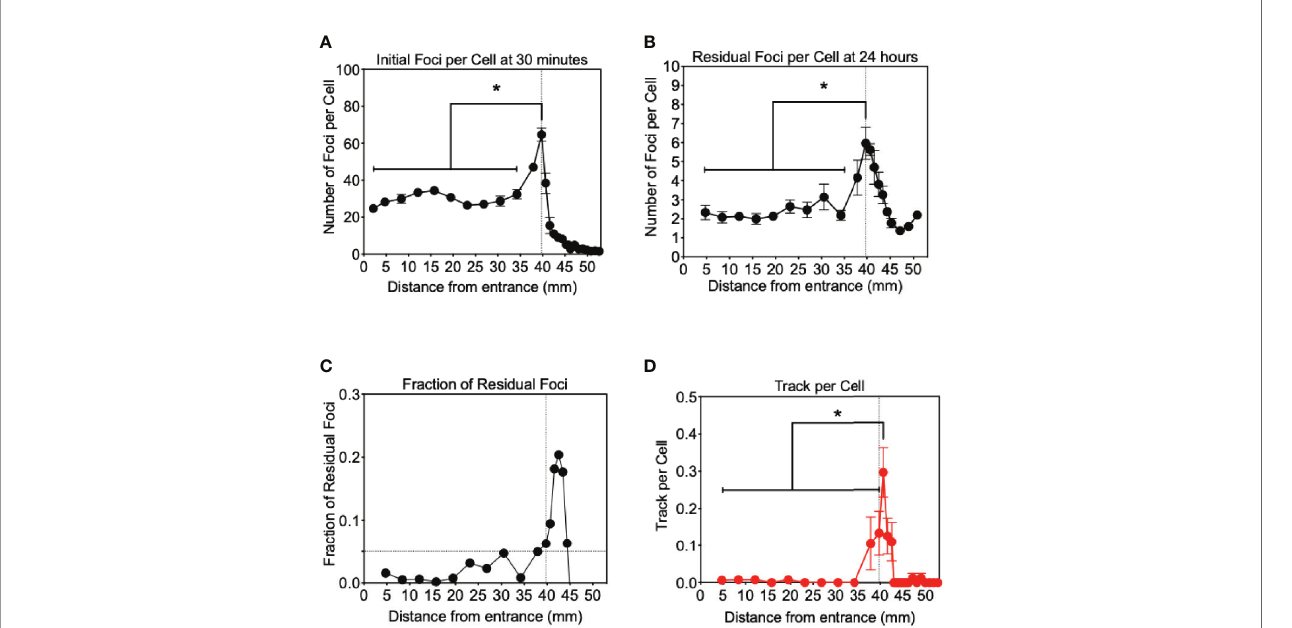
FIGURE 4 | Analysis of g -H2AX foci after proton beam irradiation for CHO wild type cells. (A) Initial DNA damage 30 min after 1 Gy of irradiation. (B) Residual DNA damage 24 h after 1 Gy of irradiation. (C) Fraction of residual DNA damage obtained by residual foci number divided by initial foci number. (D) Track like foci pattern formation at 30 min after irradiation. Vertical lines indicate the peak of Bragg peak at 39.75 mm of initial foci formation. Horizontal line indicates the fraction of residual foci of 0.05. Error bars indicate the standard error of the means. * indicates statistically signi fi cant differences (P <